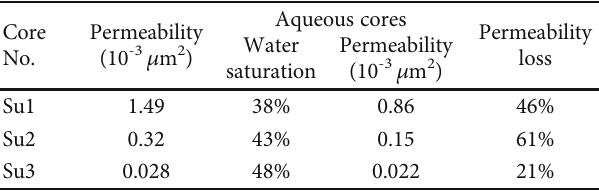
Figure 1: Measurement of multipoint embedded measurement in gas reservoir development. Table 3: Changes of related parameters between dry core and aqueous